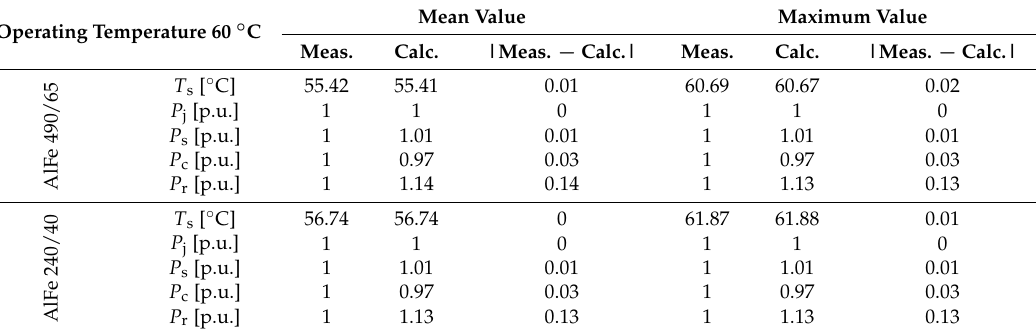
Table 11. Measured (meas.) and model-calculated (calc.) mean and maximum values of the conductor temperature, heating and cooling powers (per unit values) for conductors AlFe 490/65 and AlFe 240/40 at 60 ◦ C after optimization.